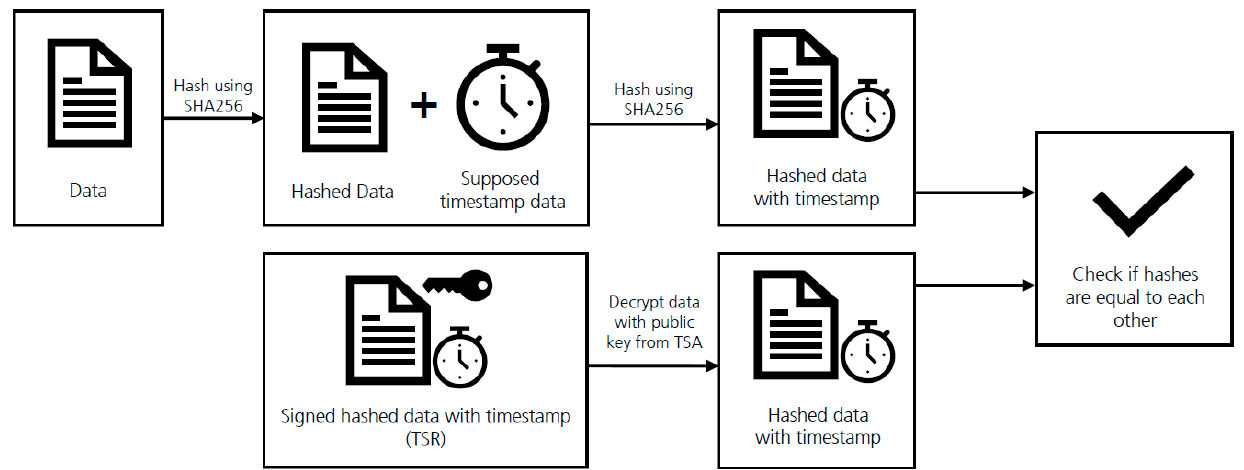
Figure 2. Verification process of timestamped data [41].